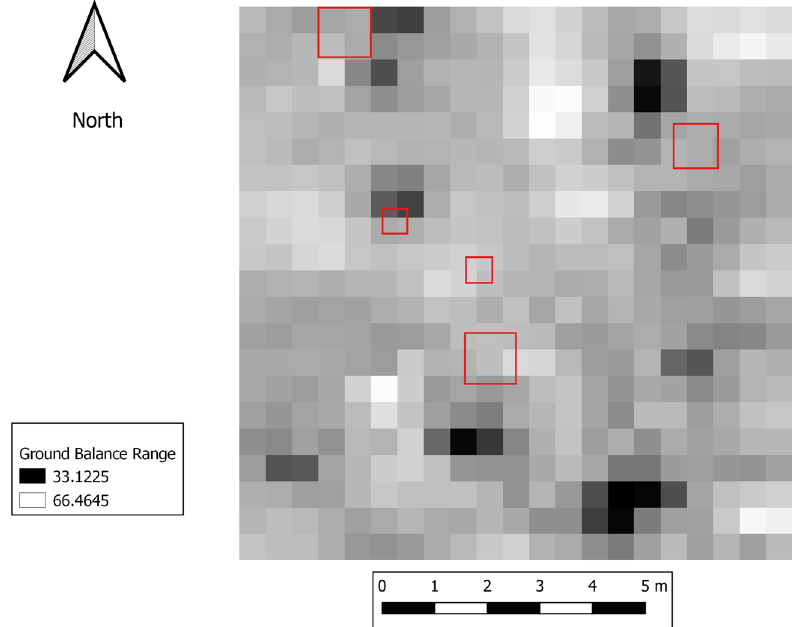
Figure 7: Interpolation map of Round Top A ground balance readings. Test units in